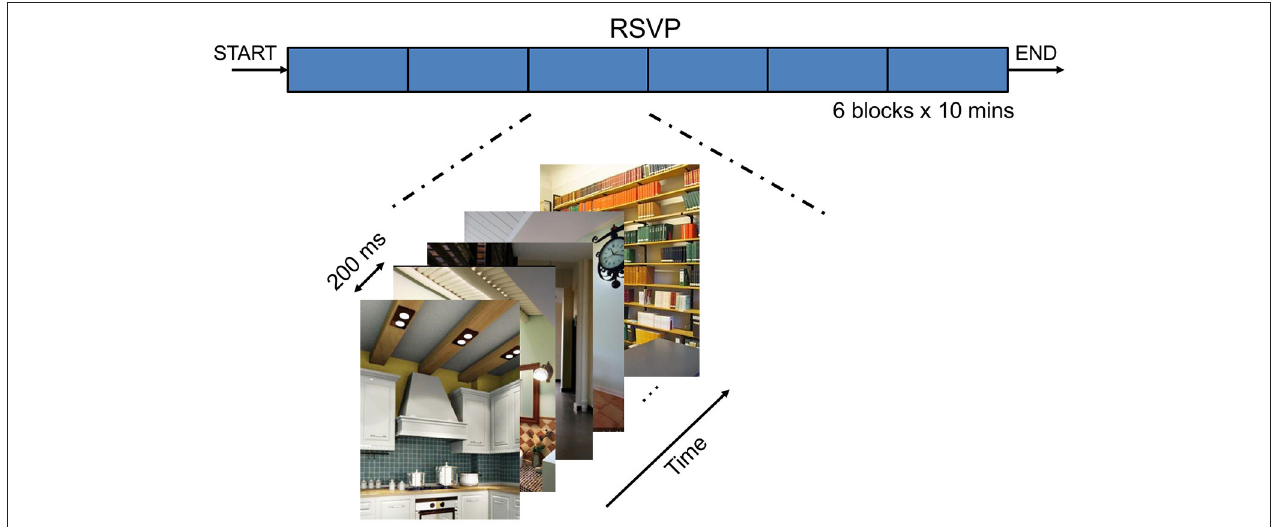
TABLE 1 | Area (Az) under the receiver operating characteristic (ROC) curve of comparative models. Human Machine Fusion method HDCA XD + BLDA CSP + BLDA BTN TAG LR FI WAS FDMF Mean 0.645 0.711 0.616 0.640 0.828 0.844 0.855 0.860 0.896 Std 0.050 0.045 0.049 0.066 0.020 0.020 0.015 0.020 0.024 StatisticalTest + + + + + + + + N/A H, HDCA; X, XD + BLDA; C, CSP + BLDA. The symbol + refers to a situation in which the average accuracy of the proposed FDMF is significantly different compared to a comparative model suggested by post-hoc comparisons (Paired t-test, p < 0.05). Bold value indicates the best